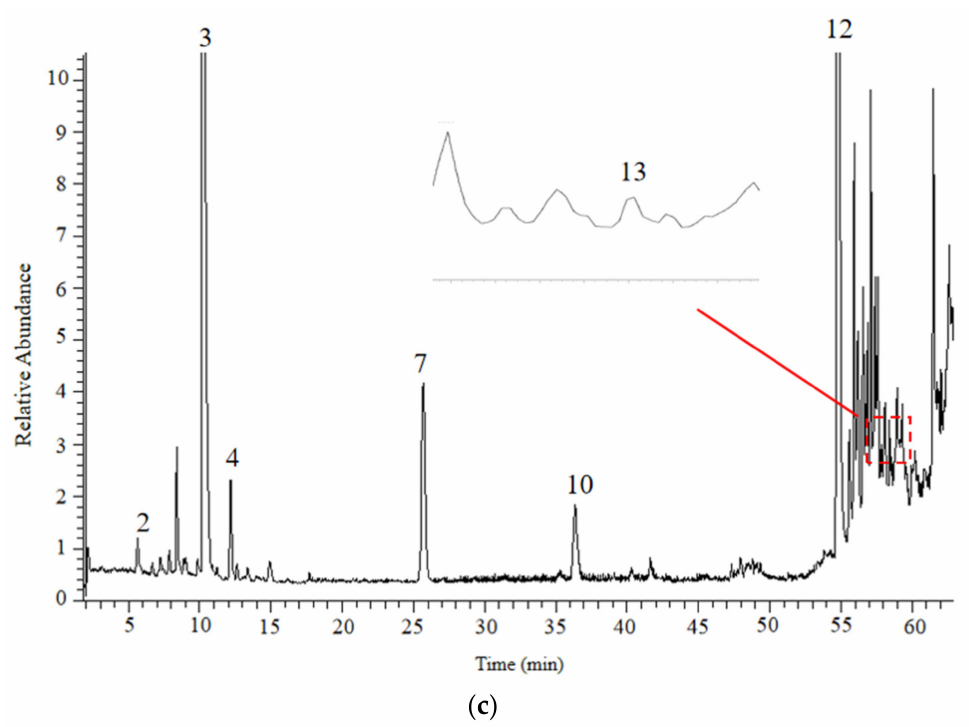
Figure 1. The BPCs of PM and PMP in the negative ion mode: mixed reference substance ( a ); PM in negative ion mode ( b ); PMP in negative ion mode ( c